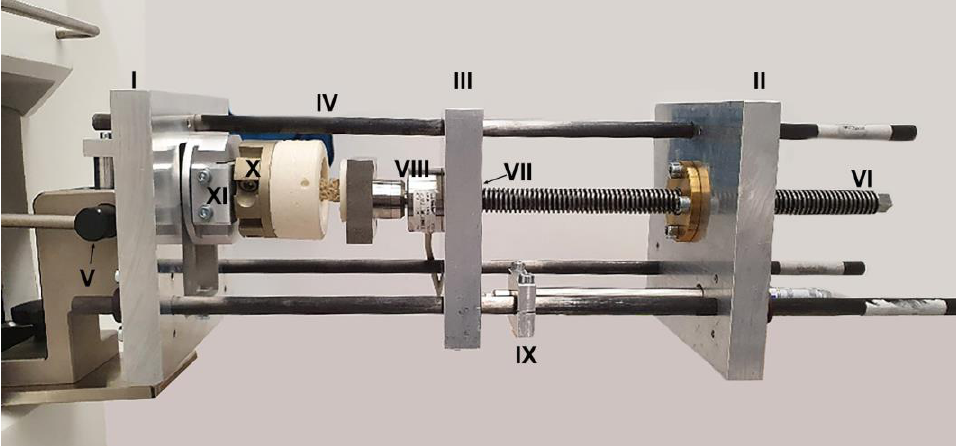
Figure 1. The compression device: The basic structure consists of three steel plates; front, rear, and center plate (I, II, III). The front and rear plates are connected by three cylindrical carbon rods (IV). Reference ball pivots (V) are attached to the front and rear plates, from which the compression device can be suspended in the XtremeCT II. The ball pivots represent the only contact surface to the XtremeCT II. The center plate is suspended on the carbon rods, which can move freely along the rods. A threaded spindle (VI) fixed via a spindle nut (VII) on the center plate exercises compression load on the specimen to adjust the compression intensity. The cylindrical block of embedding material was screwed to a flange (X), which is attached in the compression device to a mounting mechanism (XI). Force is measured by the load cell (VIII) and displacement by the LVDT sensor (IX).